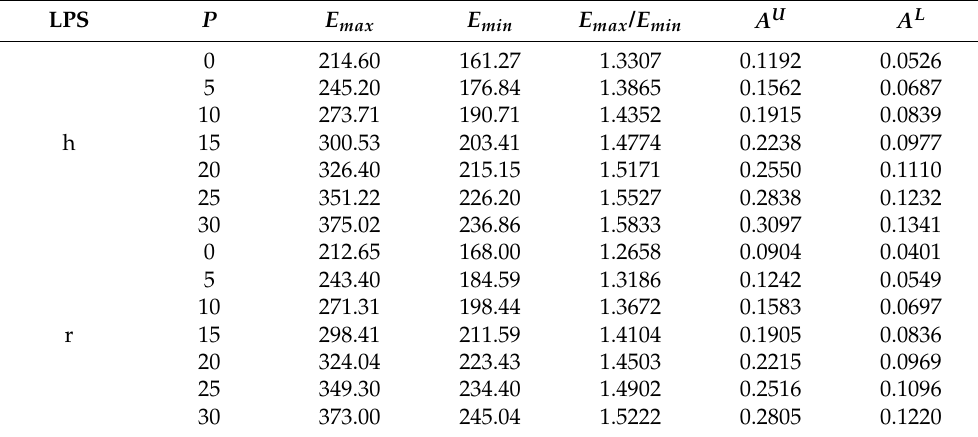
Table 7. Calculated maximal ( E max ) and minimal ( E min ) values of Young’s modulus, the ratio of